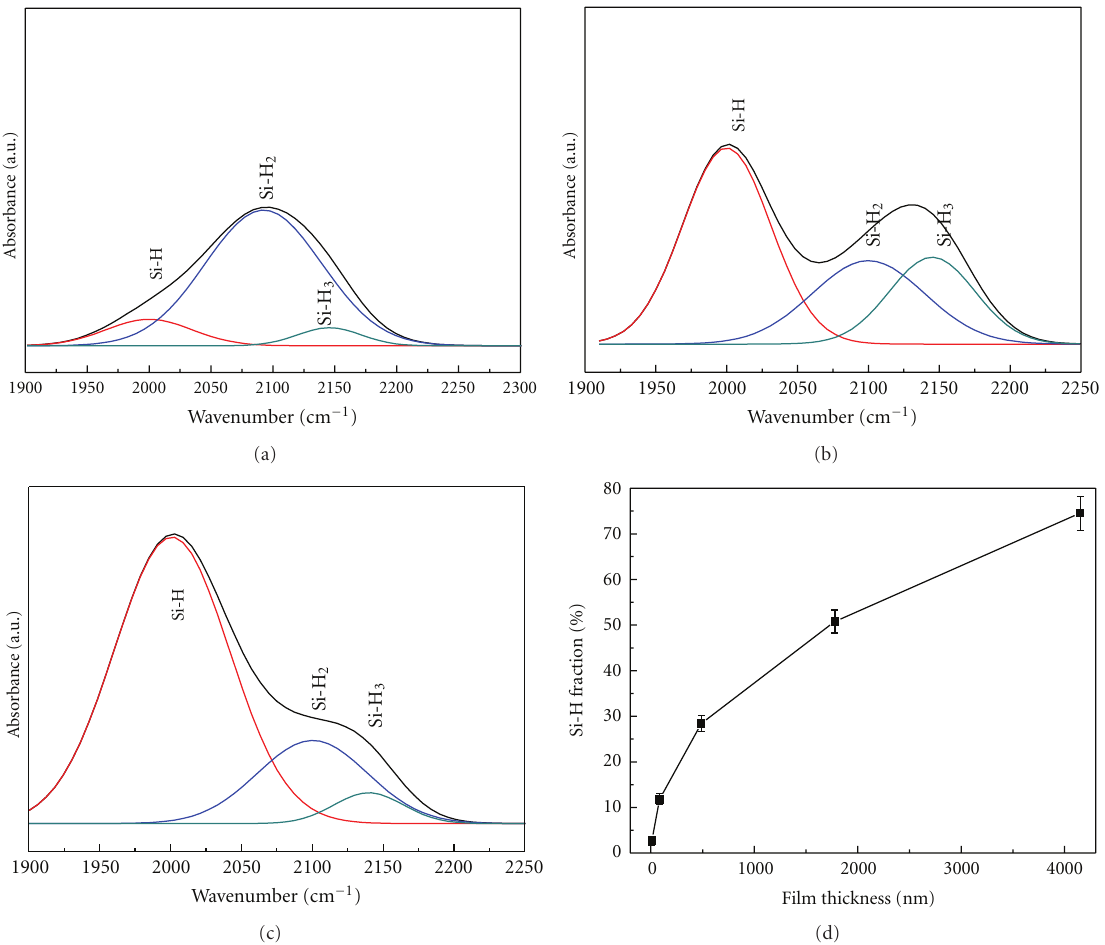
Figure 4: FT-IR results. The spectra were obtained from the films prepared for (a) 30, (b) 60, and (c) 360 min. (d) Si–H bonding fractions versus film thickness.